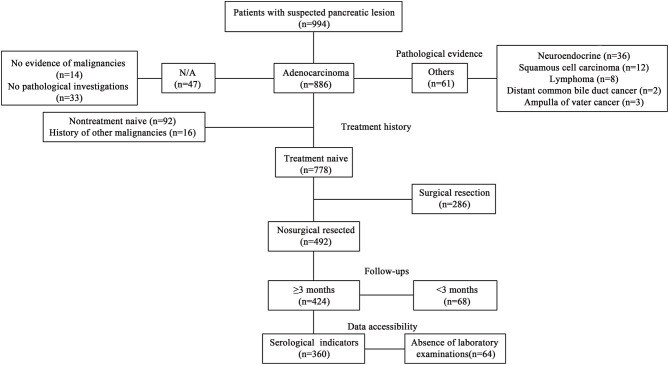
Patient inclusion flow.